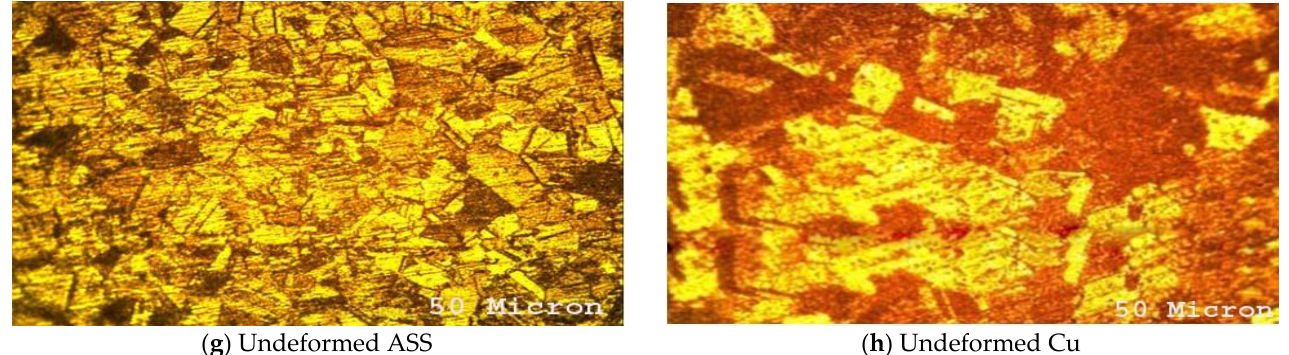
Figure 4. Optical micrograph of various regions of dissimilar joint.